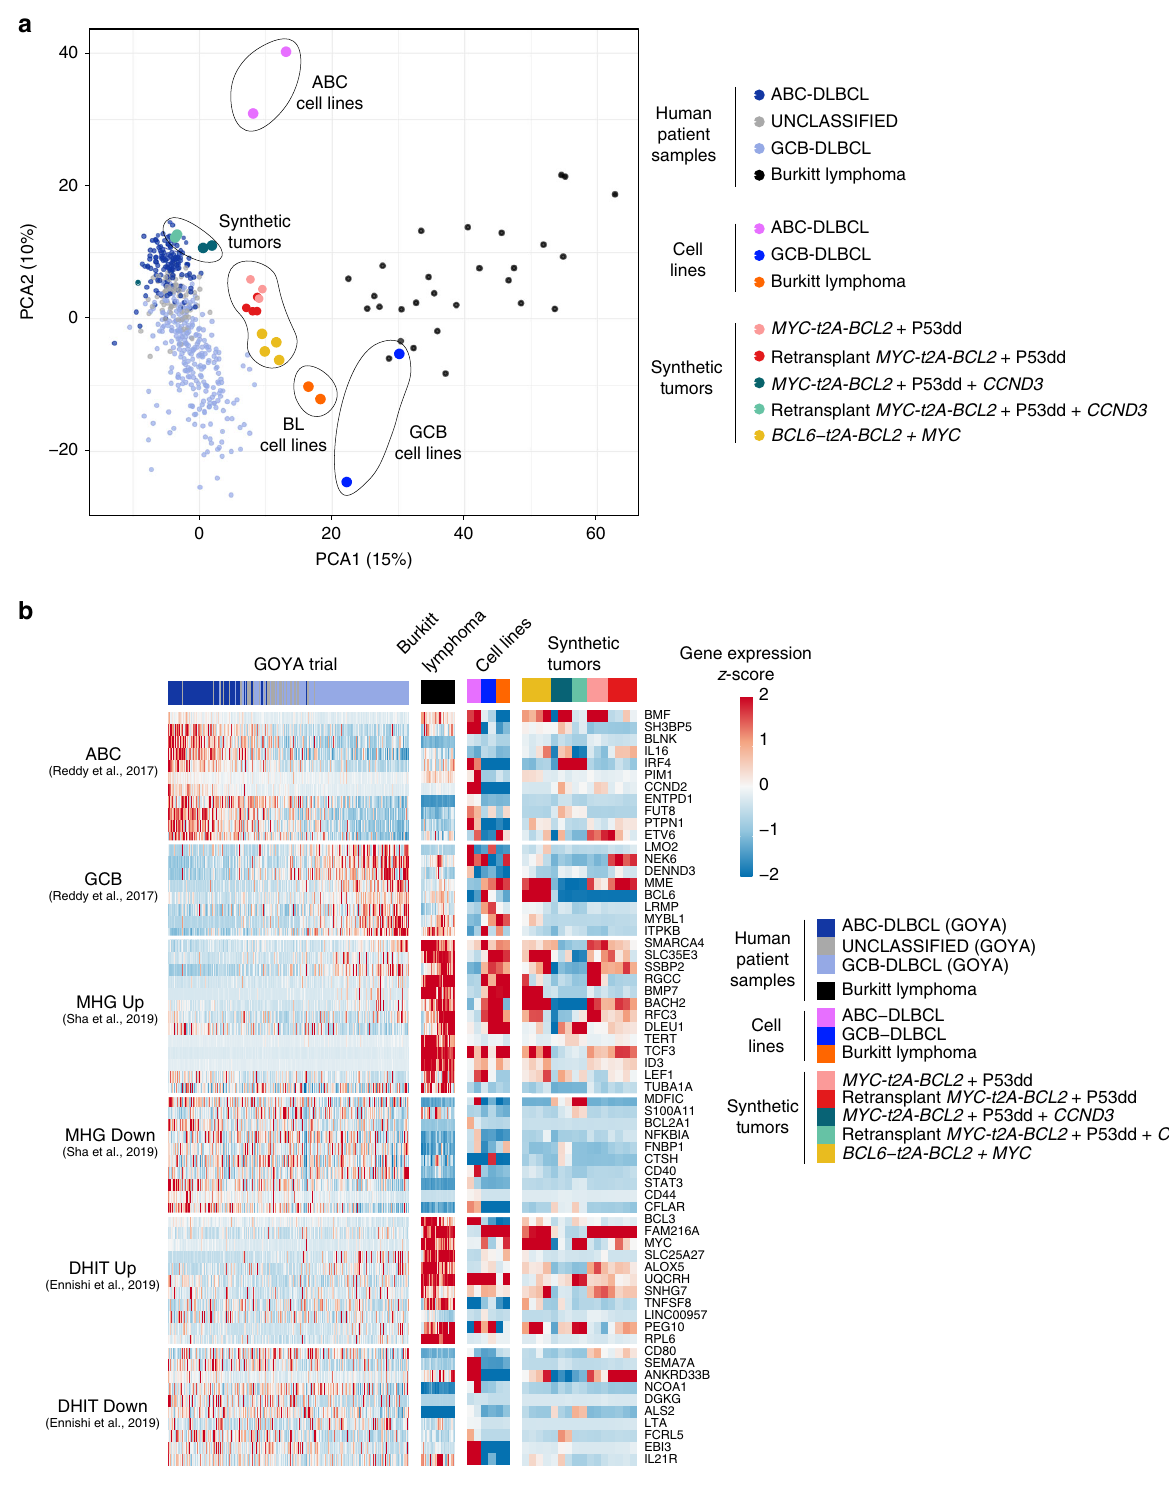
Fig. 6 Similarity of synthetic tumors to subsets of bona fi de human lymphomas and cell lines. a PCA plots showing human patient samples (GOYA trial, n = 504; Burkitt lymphoma, n = 28), lymphoma cell lines (Burkitt lymphoma n = 2 (Raji, Mutu), ABC-DLBCL n = 2 (TMD8, HBL1), GCB-DLBCL n = 2 (SUDHL4, DOHH2) and synthetic tumors ( BCL6-t2A-BCL2 + MYC n = 4, MYC-t2A-BCL2 + P53dd n = 3, Retransplant MYC-t2A-BCL2 + P53dd n = 4, MYC- t2A-BCL2 + P53dd + CCND3 n = 3, Retransplant MYC-t2A-BCL2 + P53dd + CCND3 n = 2). PCA was based on expression of 858 genes differentiating between ABC- and GCB-DLBCL subtype as described in Schmitz et al. 2 . b Heat map of gene expression of human patient samples (GOYA trial, n = 504, Burkitt lymphoma, n = 28), lymphoma cell lines (Burkitt lymphoma n = 2 (Raji, Mutu), ABC-DLBCL n = 2 (TMD8, HBL1), GCB-DLBCL n = 2 (SUDHL4, DOHH2)) and synthetic tumors ( BCL6-t2A-BCL2 + MYC n = 4, MYC-t2A-BCL2 + P53dd n = 3, Retransplant MYC-t2A-BCL2 + P53dd n = 4, MYC-t2A-BCL2 + P53dd + CCND3 n = 3, Retransplant MYC-t2A-BCL2 + P53dd + CCND3 n = 2). Selected gene signatures are described in Supplementary Table 1. MHG molecular high grade, 34 DHIT double HIT